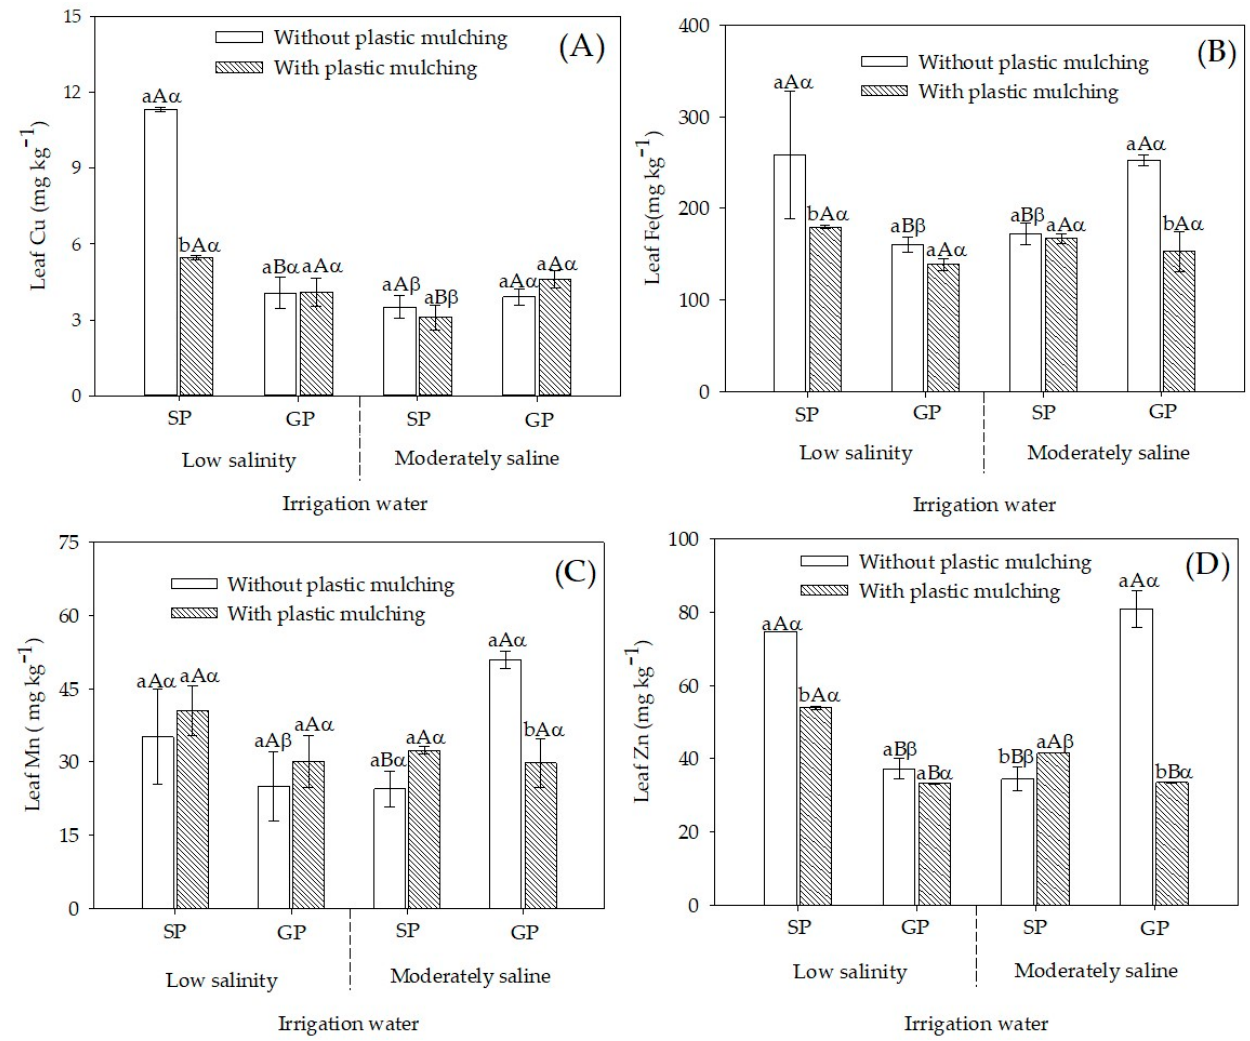
Figure 3. Concentration of micronutrients in leaves of sour passion fruit by seed-propagated and grafted propagated irrigated with low salinity and moderately saline waters with and without plastic mulching. ( A ) Cu, ( B ) Fe, ( C ) Mn, ( D ) Zn concentration in sour passion fruit seed-propagated (SP) and grafted propagated (GP) on Passiflora cincinnata irrigated with low salinity and moderately saline water in soil with and without plastic mulching. Vertical bars represent the standard error of the mean (n = 4). Bars with the same lower-case letter are similar for soil without and with plastic mulching by the F-test ( p > 0.05). Bars with the same uppercase letter are similar for seed propagation and grafting by the F-test ( p > 0.05). Bars with the same Greek letter are similar for irrigation with low salinity and moderately saline water by the F-test ( p > 0.05).